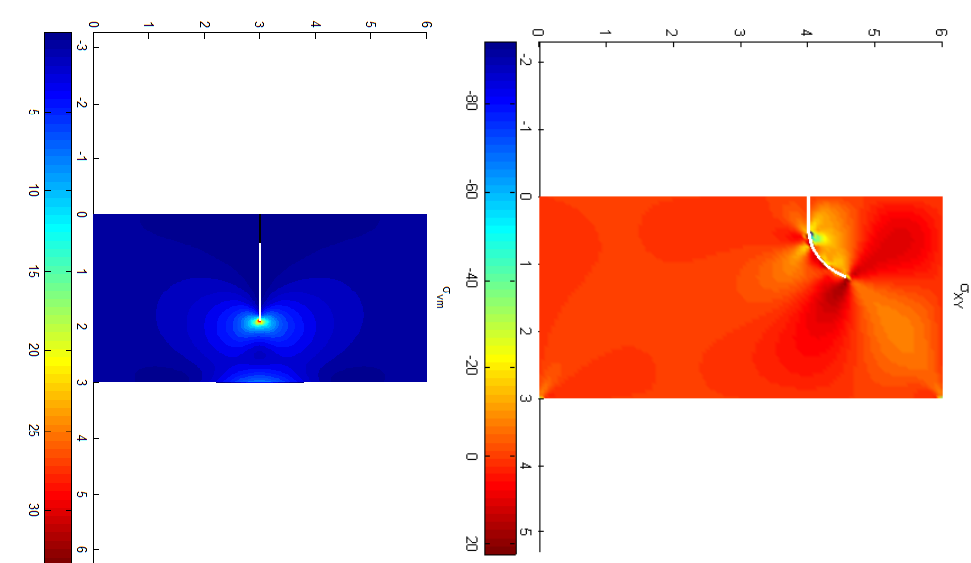
Figure 14. Edge crack propagation, centered edge crack (left), off-centered edge crack